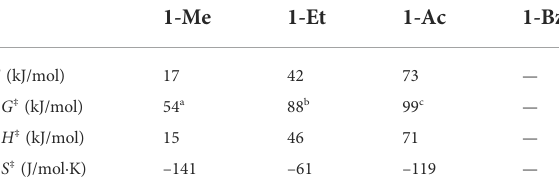
TABLE 1 Thermodynamic parameters in mechanostereoinversion of